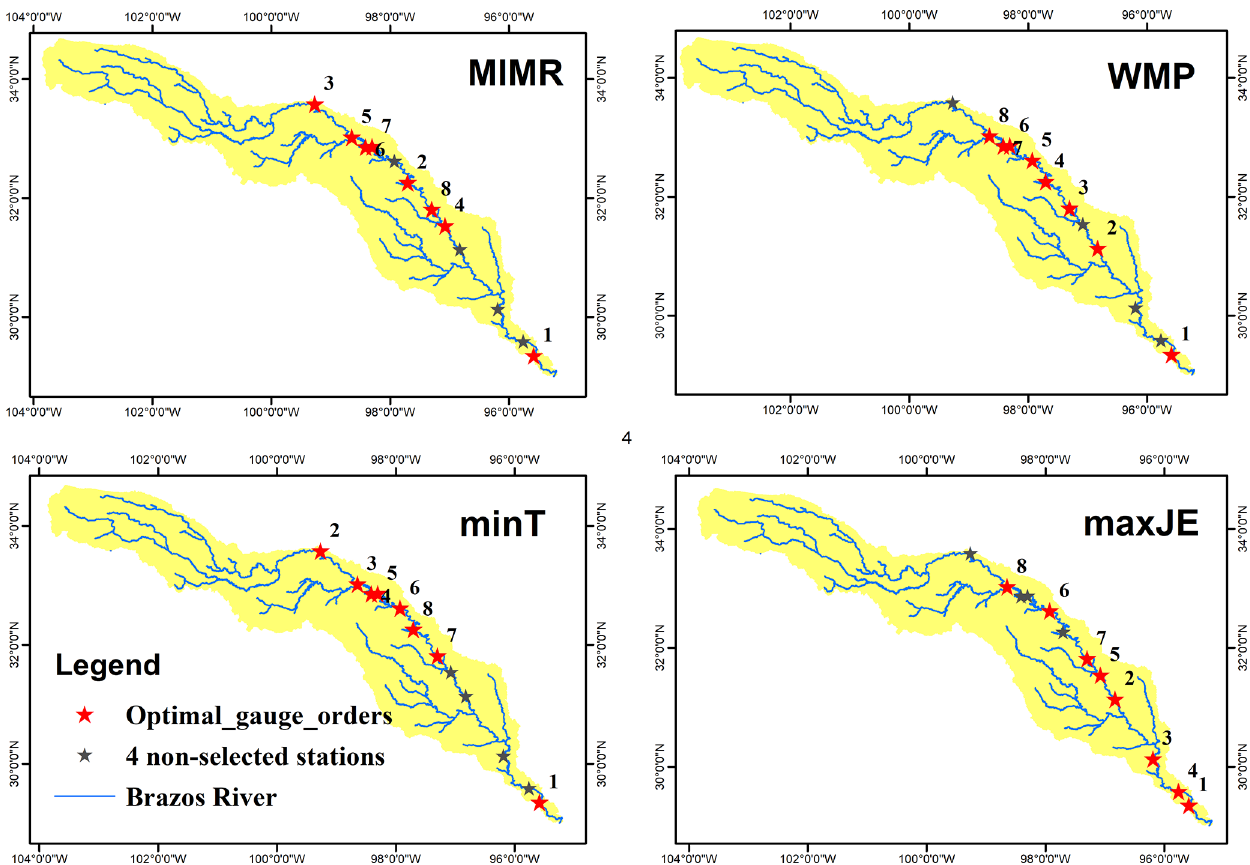
Figure 5. Spatial distribution of the top eight streamflow gauges ranked by different objectives.